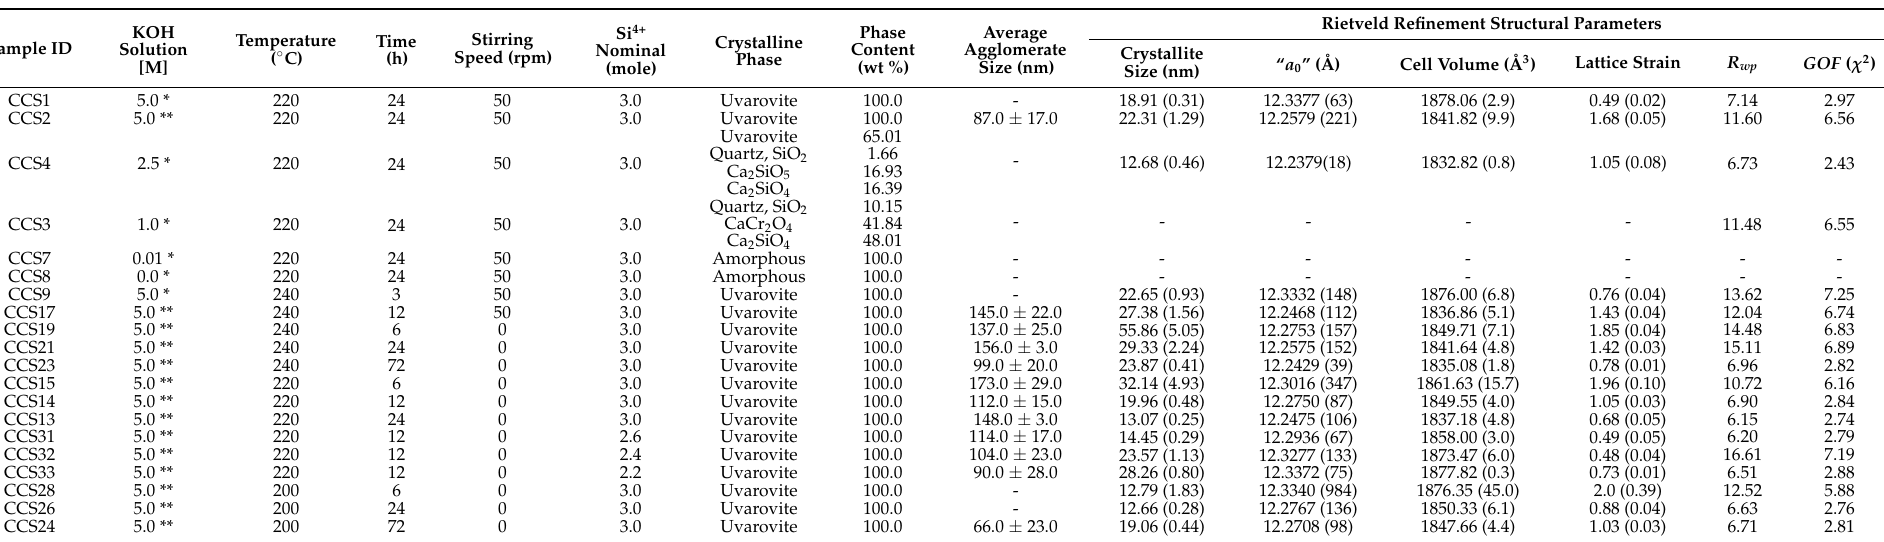
Table 1. Summary of the relevant experiments selected to investigate the hydrothermal synthesis of single-phase Ca 3 Cr 2 Si 3 O 12 particles and relevant Rietveld refinement results. The experiments were carried out with two volumes of the KOH solution 18.5 * and 12.5 **